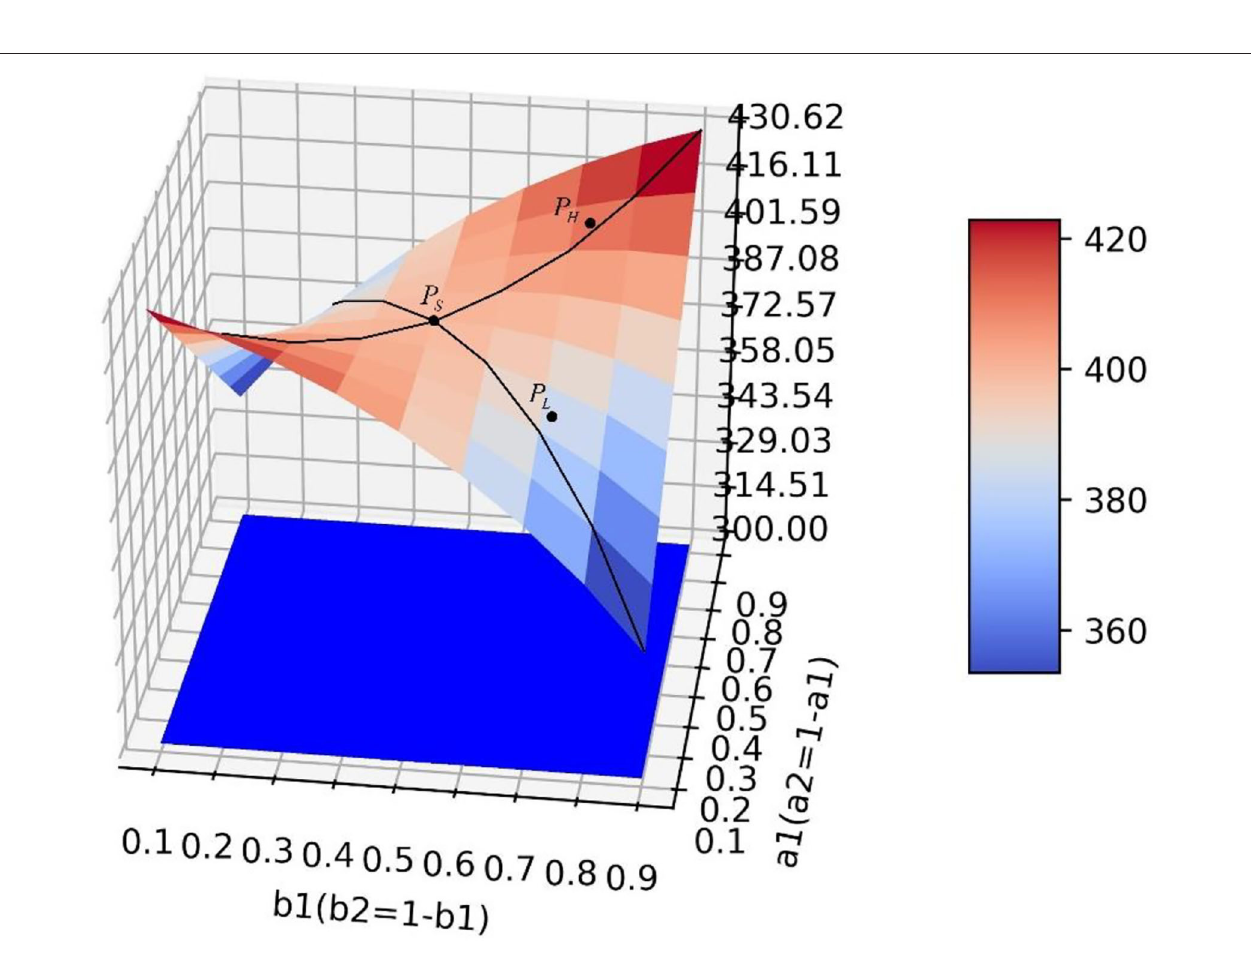
FIGURE 11 | In the scene of simulation 4, the saddle point P S on the